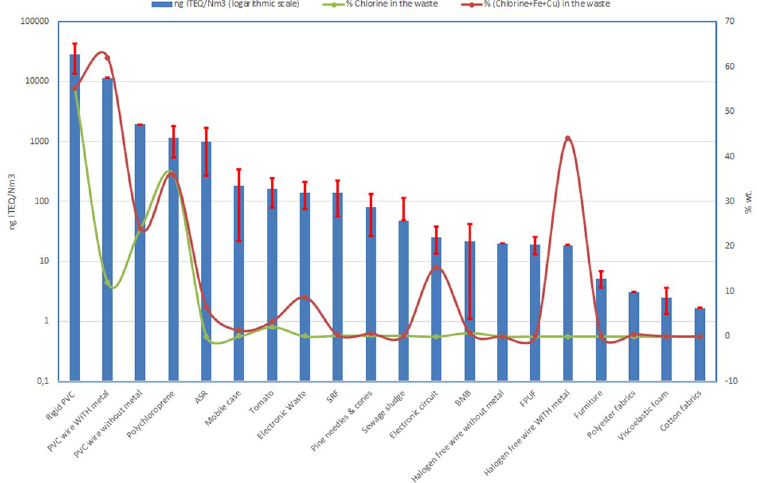
Figure 7. Emissions of PCDD/Fs from the thermal decomposition of different wastes (average of runs performed under different conditions, with standard deviation) and chlorine and metal content in the waste